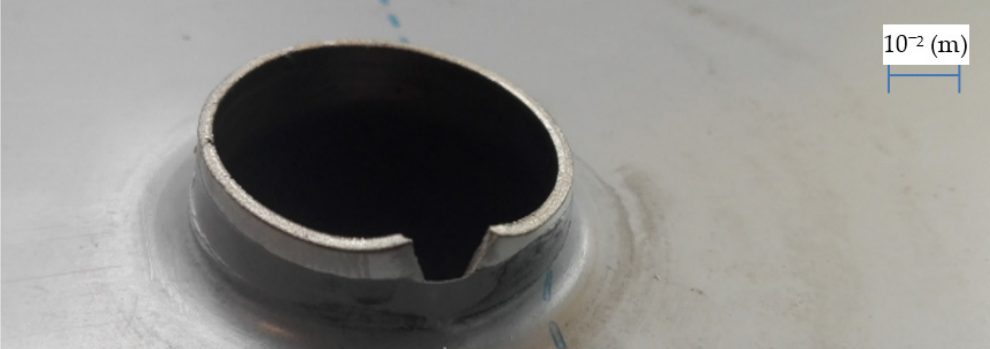
Figure 17. An example of a test sample after the flange extrusion process for the h10 model: side view. After the flange extrusion process for h6 and h10 models, the flange height and wall narrowing were measured. The detailed results are summarized in Tables 2–4. The results of the measurements of internal diameters and flange height were made with an accuracy of ± 0.02 × 10 − 3 (m). The maximum height for the h10 model flange does not apply to the point where the material structure is broken. Table 2. Measurement results of internal diameters and flange height with a measuring accuracy of ± 0.02 × 10 − 3 (m). Sample Number